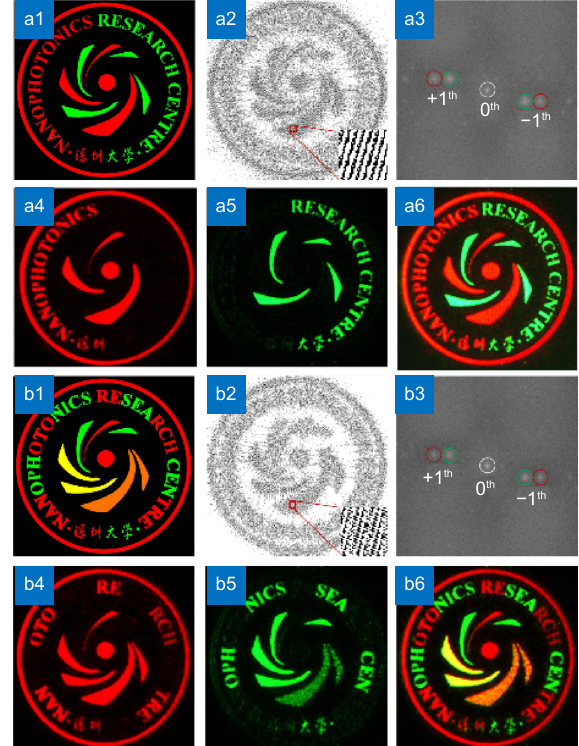
Fig. 4 | Color image display results realized using a red LD and a green LD, where the logo of our research center is used as the target structure. ( a1 ) Structural design. ( a2 ) DMD loading image, where the local magnification image shows the loaded holographic mask. ( a3 ) Spectrum plane. ( a4 ) Measured red image. ( a5 ) Meas- ured green image; and ( a6 ) measured double-color result